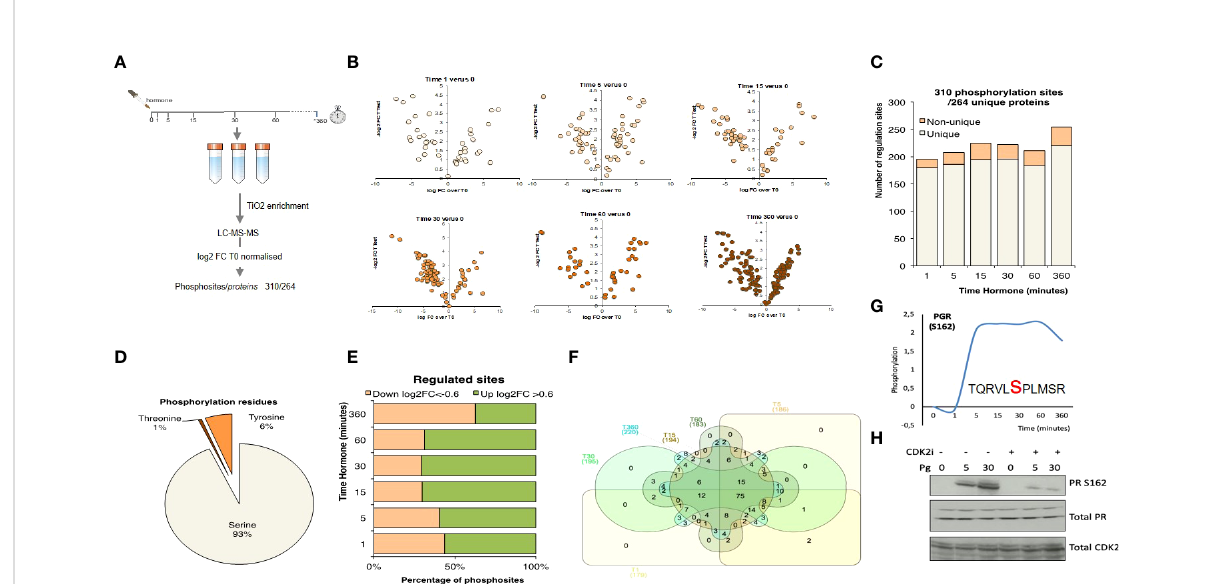
FIGURE 2 Phosphosite enriched Shotgun Proteomics following hormone. (A) T47D cells were treated with hormone at the times indicated. Biological triplicates were enriched for phosphopeptides using TiO2 followed by LC-MS-MS peptide identi fi cation. Data was log 2 normalised resulting in a total of 310 phosphosites from 264 unique proteins. (B) Volcano plots showing phosphopeptide log 2 FC versus p-value for each of the time points following hormone. (C) Number of signi fi cant phosphosites identi fi ed per time point. (D) Analysis of the proportion of threonine, tyrosine and serine phosphorylated residues identi fi ed. (E) Breakdown of up (>0.6log 2 FC) and down (<-0.6 log 2 FC) per time point versus T0. (F) Venn diagram showing the overlap of signi fi cantly regulated phosphorylation sites over time. (G) Phosphorylation of progesterone receptor PR (S162), following progesterone validated by western blotting in presence or absence of CDK2 inhibitor (H) . Total PR levels are shown as a loading